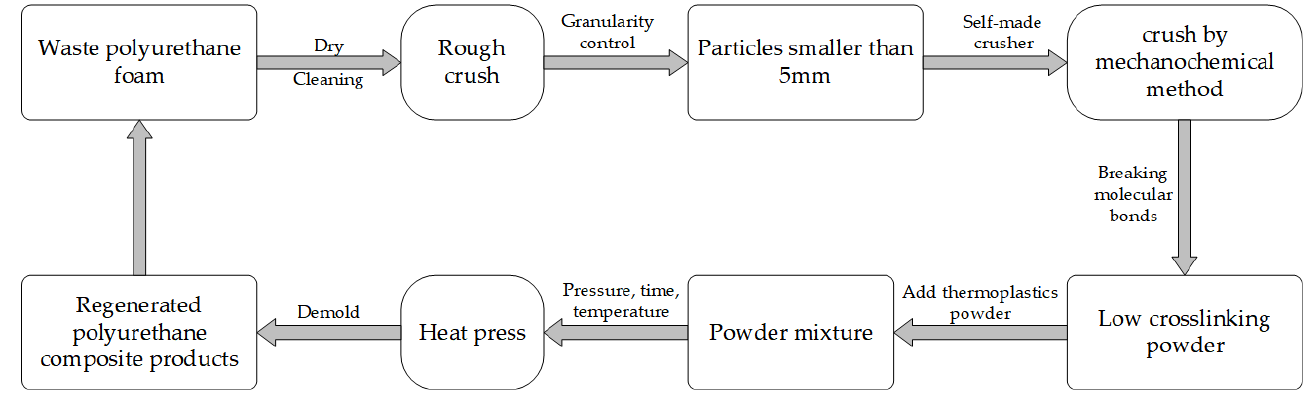
Figure 1. Recovery process of polyurethane foam by mechanochemical method.